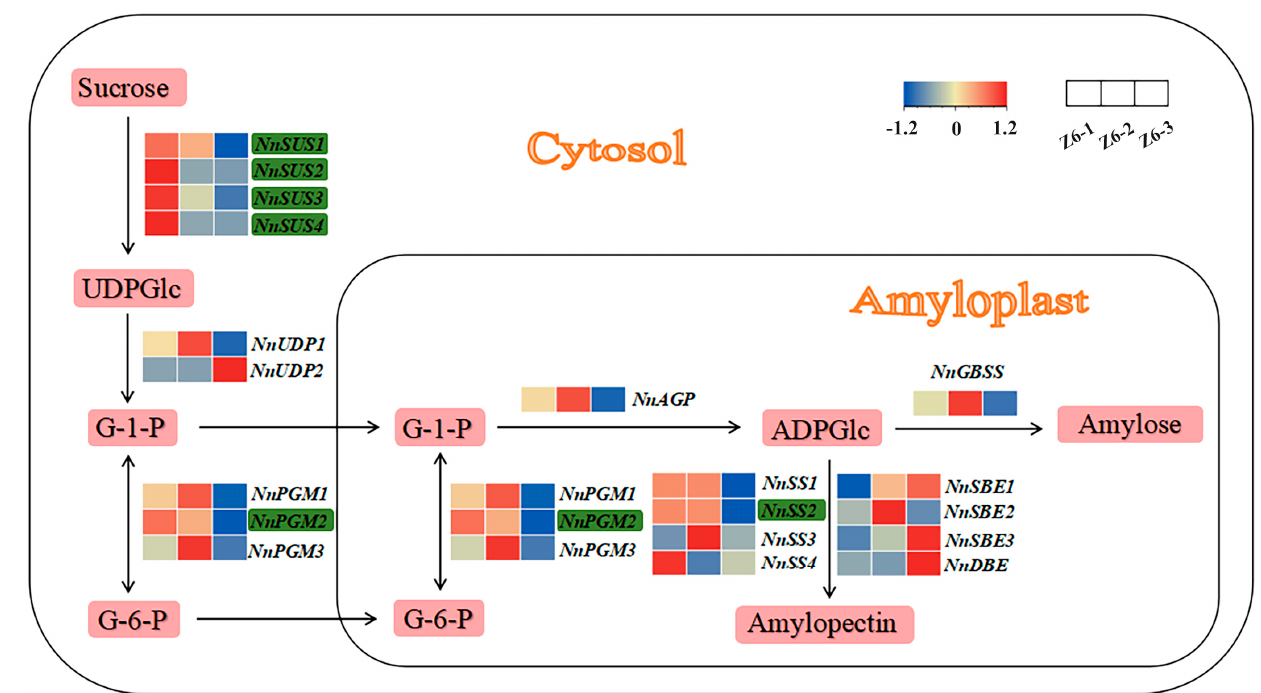
Figure 5. Expression profiles of starch biosynthetic genes. Green rectangles highlight genes down regulated from Z6-1 to Z6-3.